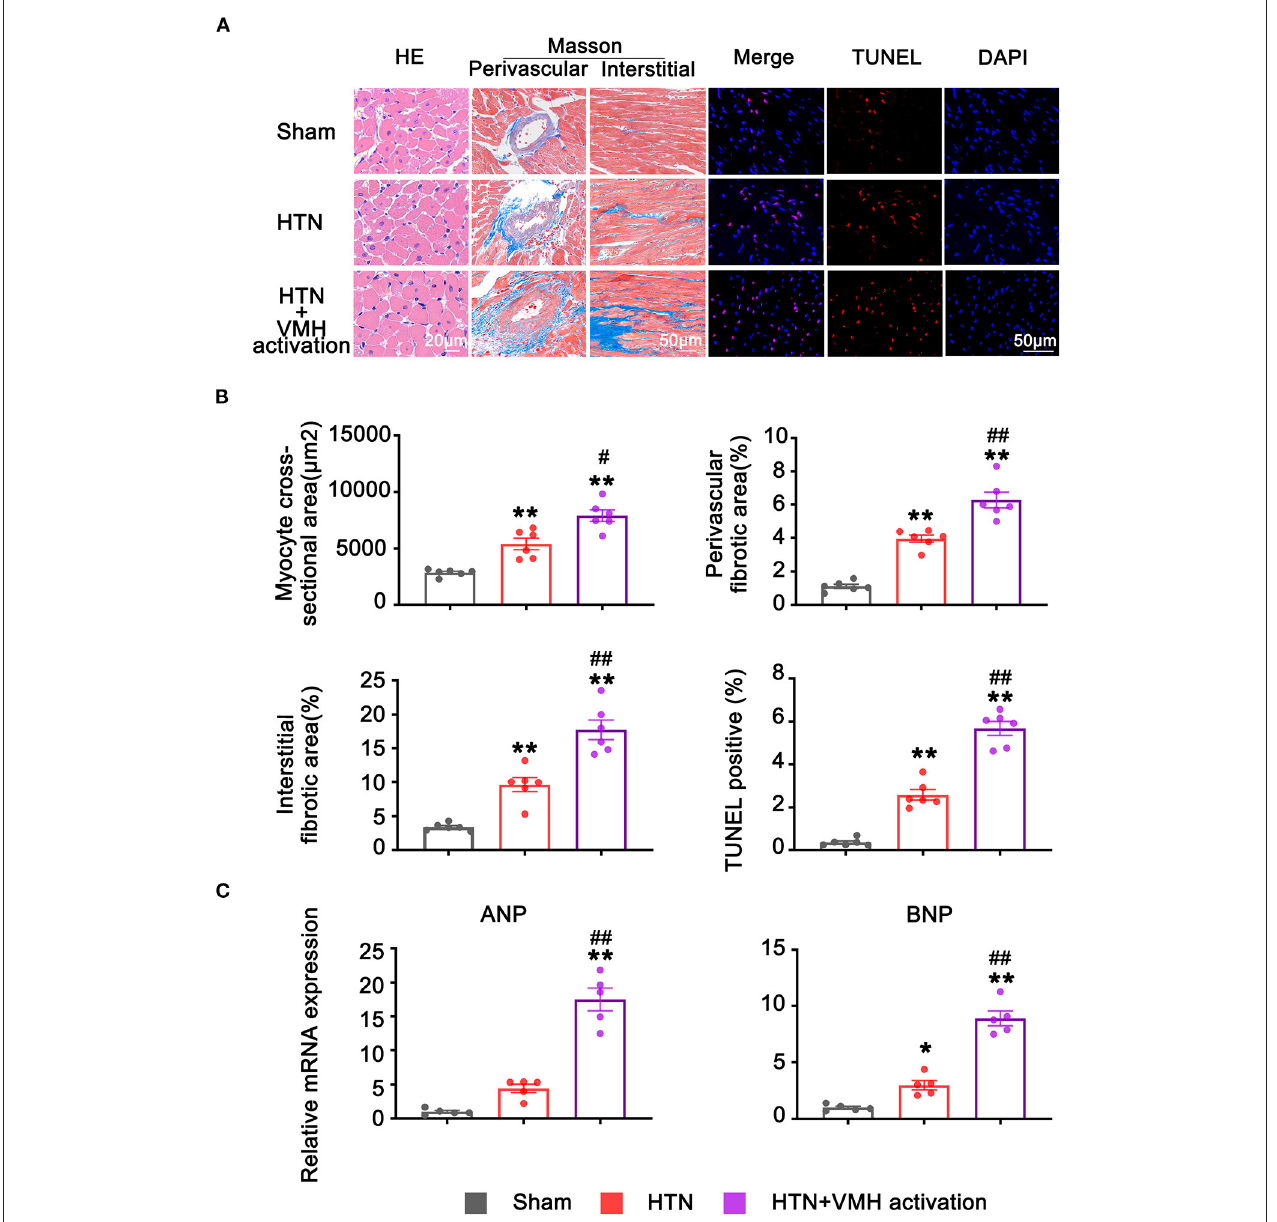
FIGURE 3 | VMH activation aggravated cardiac remodeling. (A) Representative histological staining images (the scale bar represents 20 µ m), Masson staining images (the scale bar represents 50 µ m), and TUNEL staining images (the scale bar represents 50 µ m) of left ventricle. (B) Quantification of myocytes cross-sectional areas, peripheral fibrosis areas, interstitial fibrosis areas, and TUNEL positive cells. Values are presented as mean ± SEM ( n = 6 per group). (C) The relative mRNA expression of ANP and BNP. Values are presented as mean ± SEM ( n = 5 per group). ANP, atrial natriuretic peptide; BNP, brain natriuretic peptide. * p < 0.05, ** p < 0.01; vs. sham group; # p < 0.05, ## p < 0.01 vs. HTN